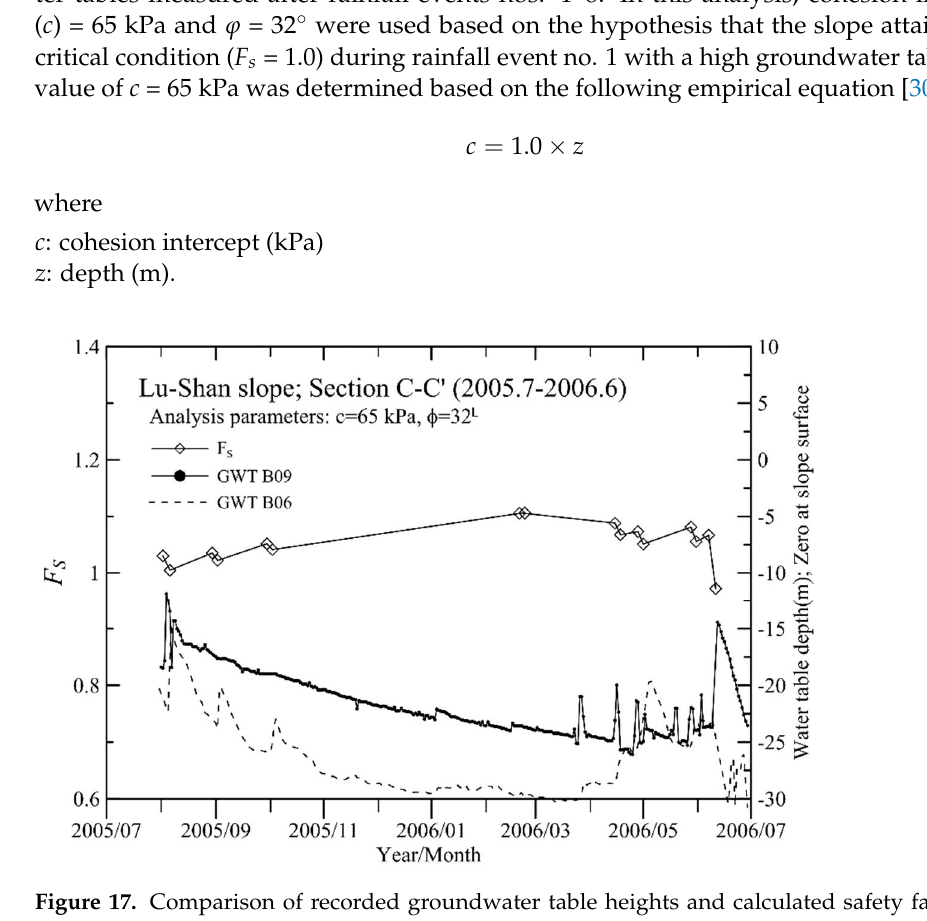
Figure 16. Comparison of cumulative slope displacements measured at various boreholes.